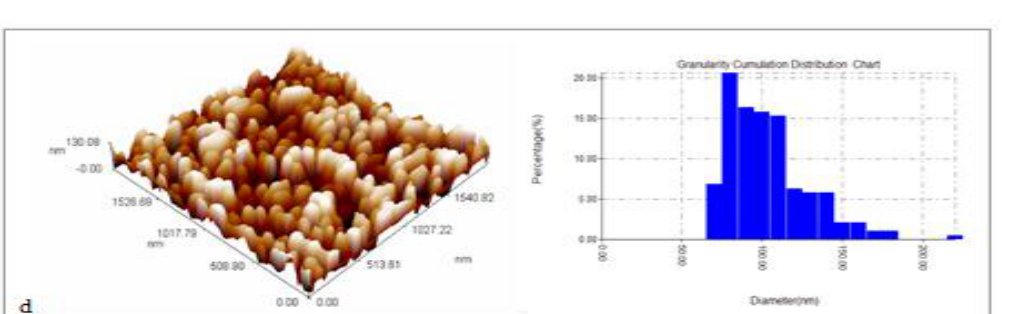
O thin films at different annealing temperature at 2 3 a- RT, b-300 o C, c-400 o C and d-500 o